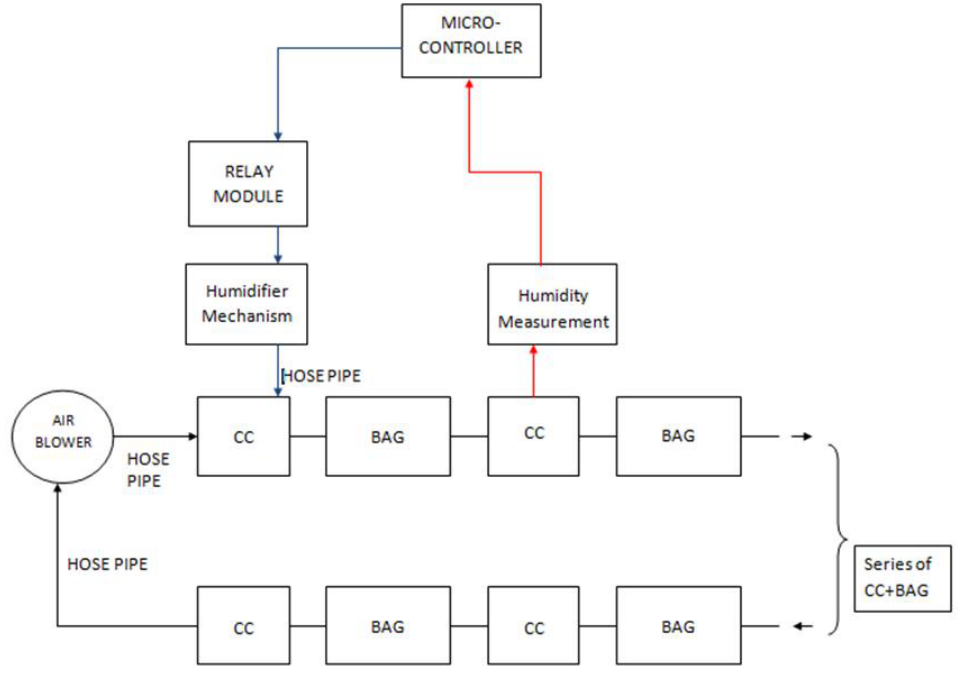
Figure 3. Simplified block diagram of MCB.